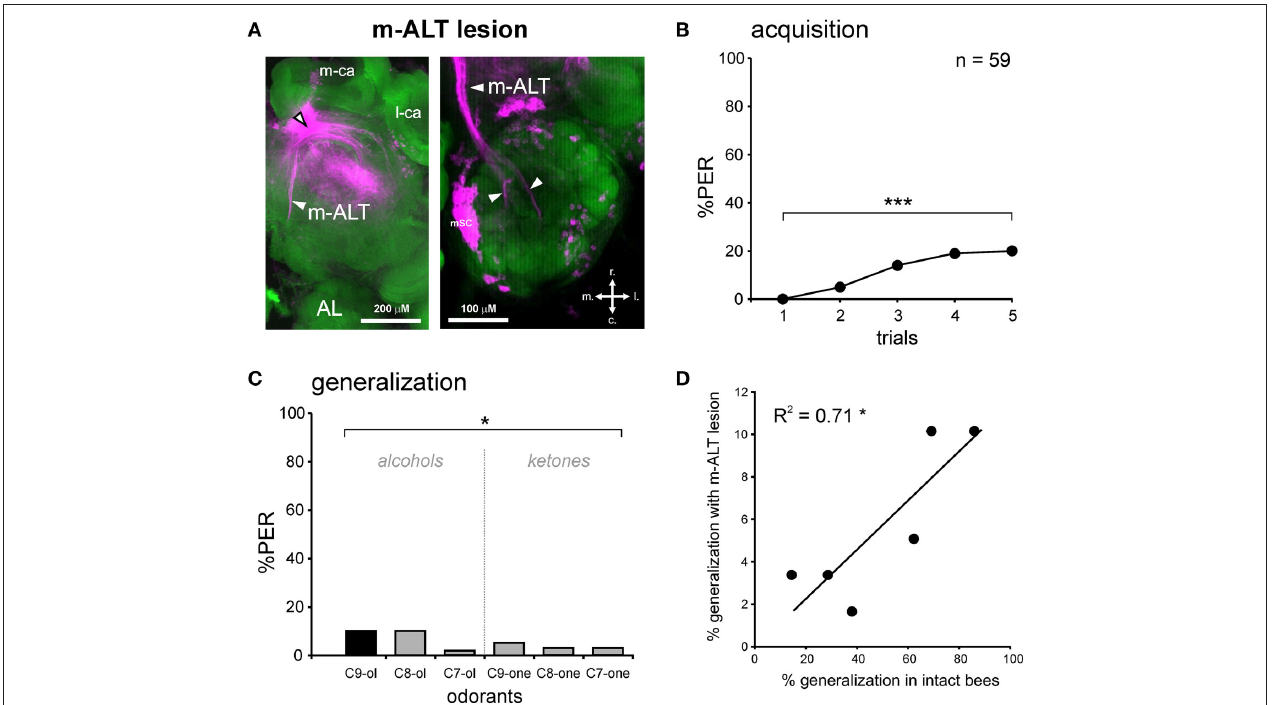
FIGURE 5 | PER conditioning and generalization tests after an m-ALT lesion. (A) Staining with tetramethylrhodamine induced by the m-ALT lesion and Alexa488 coupled to phalloidin as counter-staining. The black and white arrowhead points to the lesion site. A stained m-ALT tract (left) or the stained somata clusters of m-ALT PNs (mSC, right) were used as indicators for a successful lesion. Abbreviations: r, rostral; c, caudal; l, lateral; m, medial. (B) PER conditioning in bees with an m-ALT lesion. Only a few m-ALT lesioned bees managed to associate the odor CS (1-nonanol, C9-ol) with the sucrose reward (US), as shown by the weak increase in PER percentage with trials ( n = 59 ; *** p < 0.001 , Cochran’s Q test). (C) Generalization tests after PER conditioning, using five new odorants, shows that bees with an m-ALT lesion respond differentially to the different odorants ( * p < 0.05 , Cochran’s Q test). (D) Significant correlation between the responses of bees with an m-ALT lesion and intact bees during generalization tests ( * p < 0.05 , R 2 = 0.71 ).